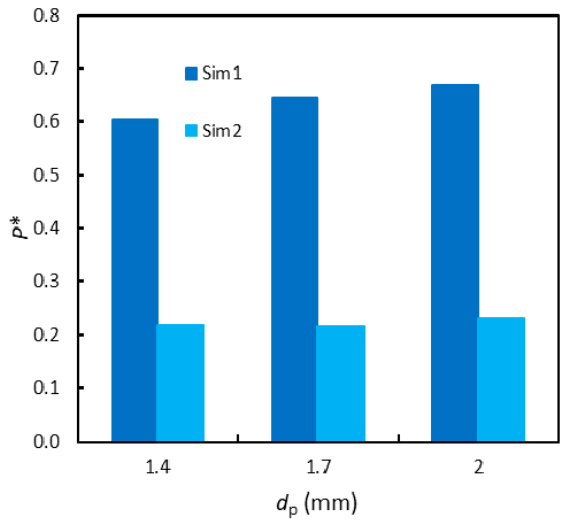
Figure 12. Pressure at the bottom upon slightly varying the particle diameter.